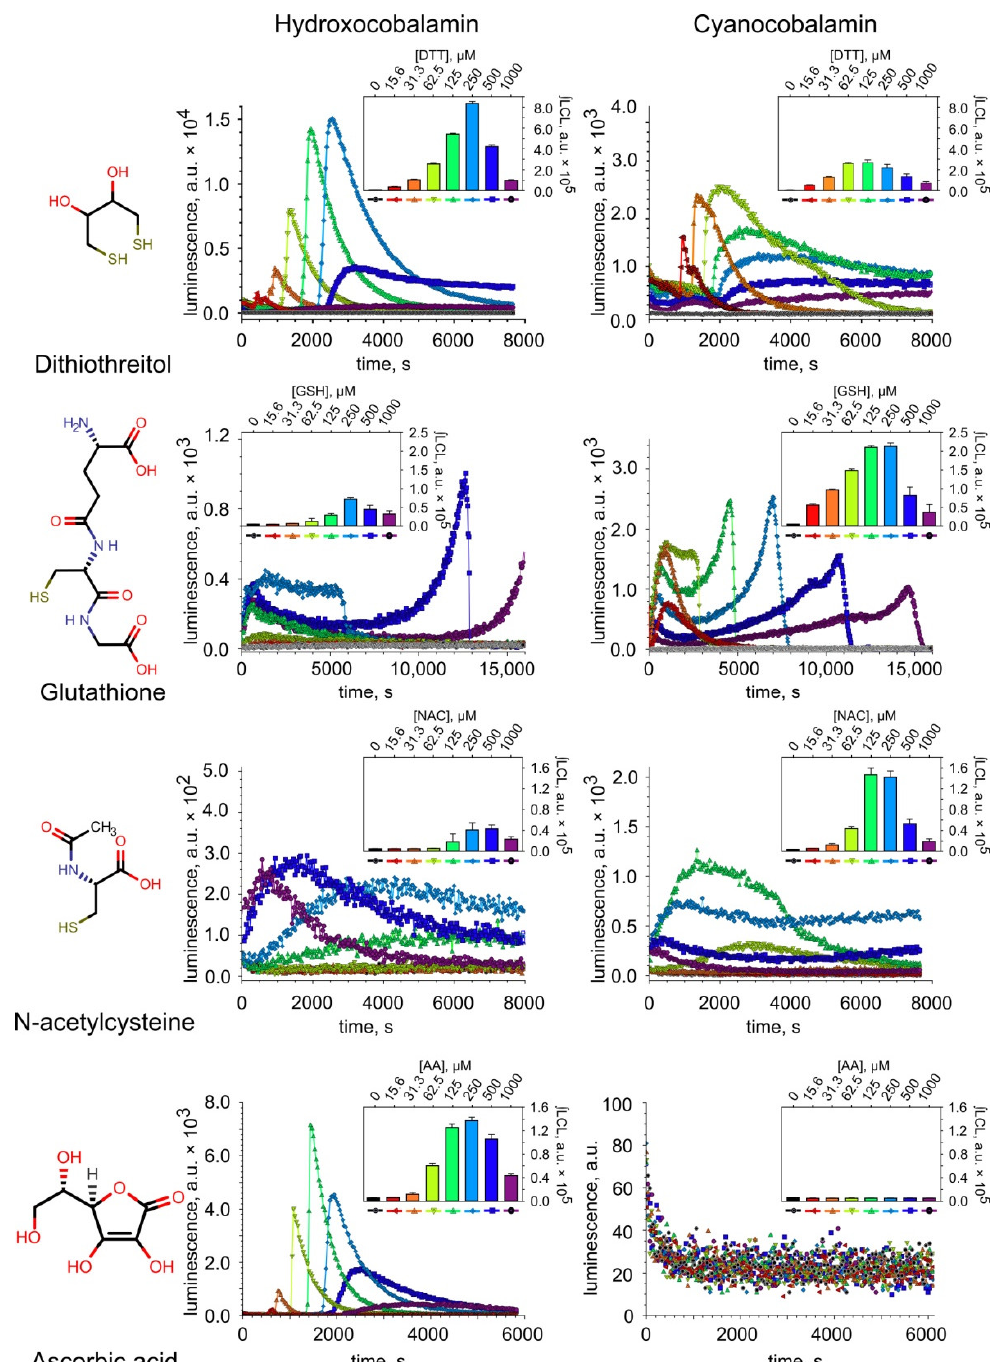
Figure 2. Chemiluminescence recorded during the oxidation of compounds tested in the presence of cobalamins. Inserts: Dependence of integral chemiluminescence response (∫LCL) on the concen- tration of the compounds.